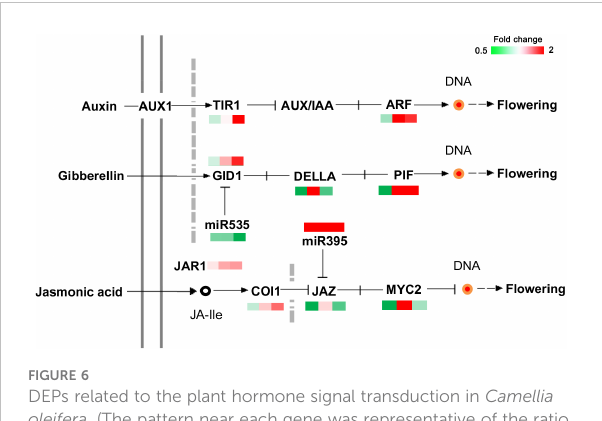
FIGURE 6 DEPs related to the plant hormone signal transduction in Camellia oleifera . (The pattern near each gene was representative of the ratio of their expression levels between MY3 and QY2. Left: MY3/QY2 at 4.14, MY3/QY2 at 4.21, right: MY3/QY2 at 4.30).